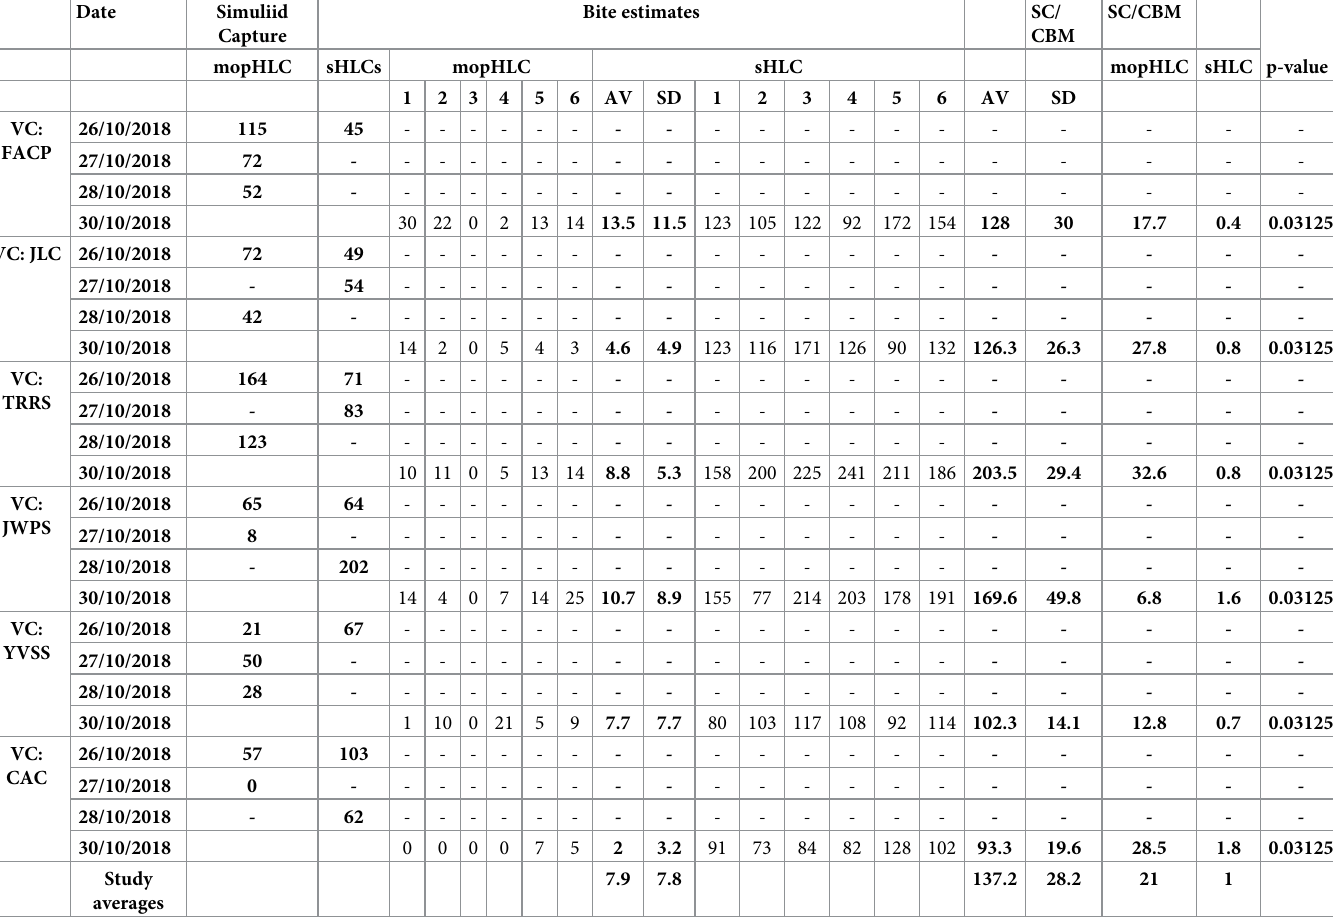
Table 2. Simuliid trapping efficiency and safety data calculated from mature bite marks and fully-blind bite